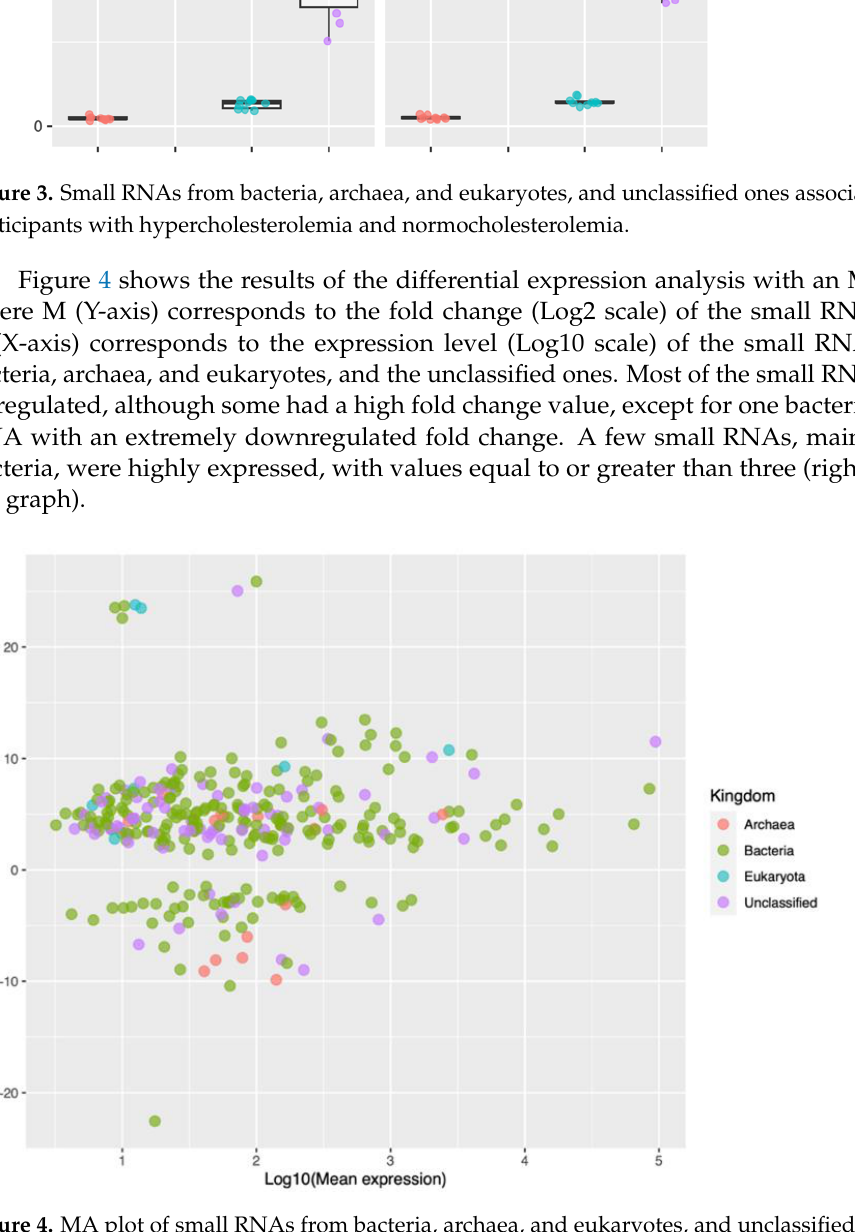
Figure 4. MA plot of small RNAs from bacteria, archaea, and eukaryotes, and unclassified